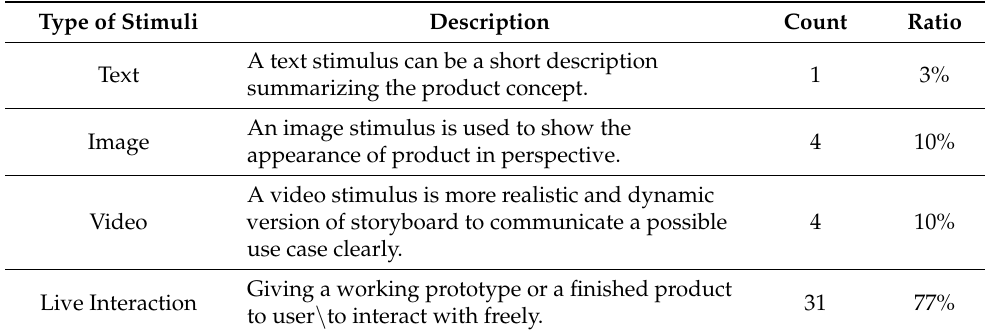
Table 1. Summary of stimuli